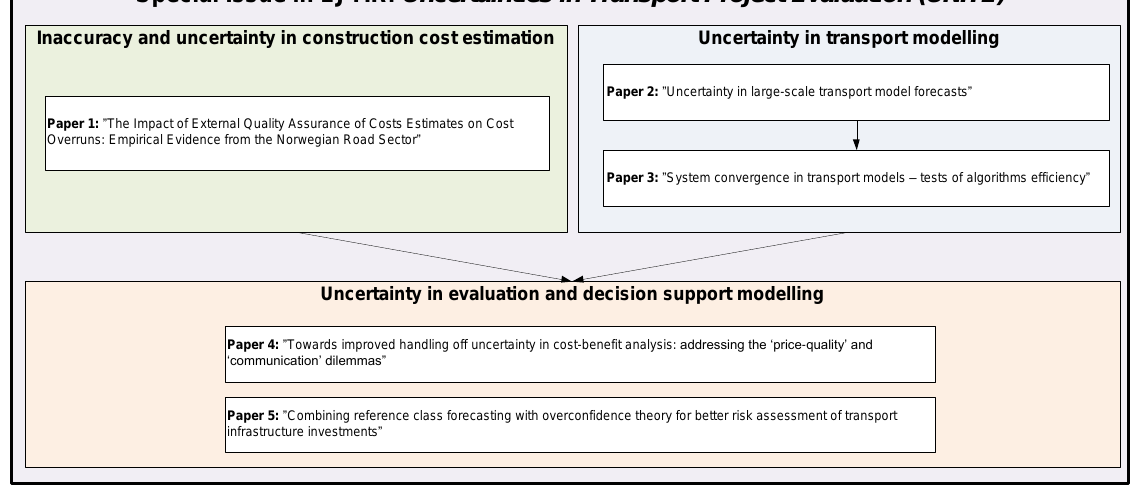
Organisation of papers within this special